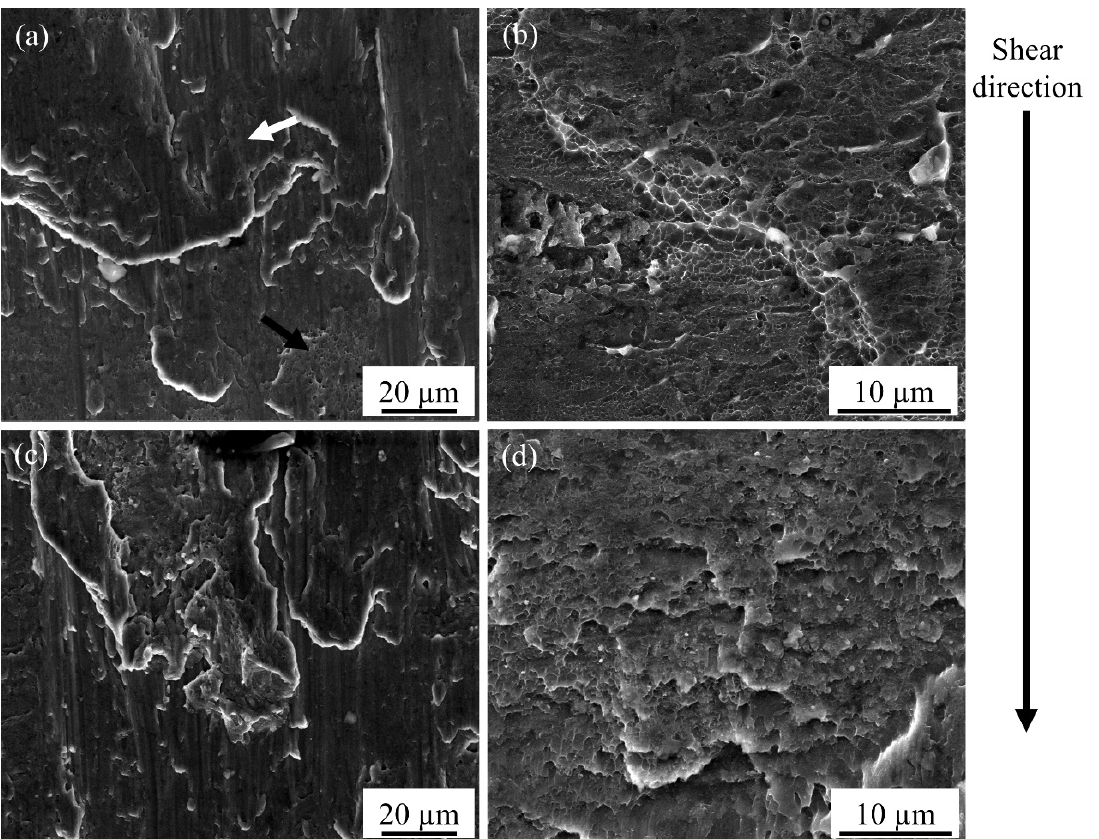
Figure 10. Fractography of AA6061 joints diffusion bonded at temperatures of ( a ) 500 °C with T4-PWHT, ( b ) 500 °C with T6-PWHT, ( c ) 530 °C with T4-PWHT, and ( d ) 530 °C with T6-PWHT.